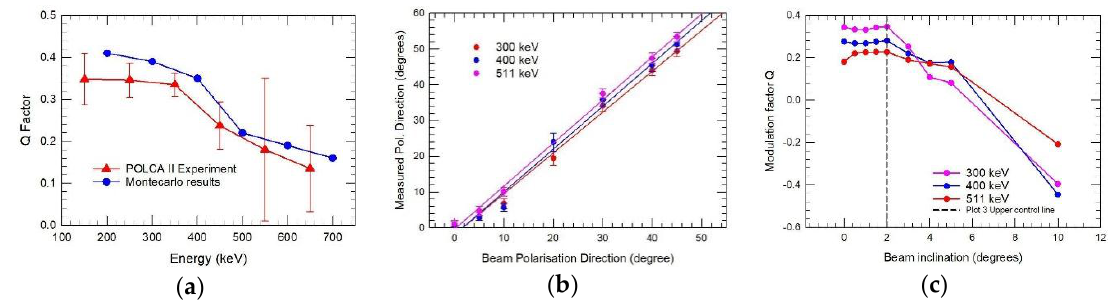
Figure 5. ( a ) The measured PolCA modulation Q 100 factor (with 1 σ errors) as function of beam energy, compared with the results of a simple GEANT Monte Carlo model (the 1 σ errors are smaller than symbols); ( b ) The polarization plane direction reconstruction (with 1 σ errors) at different energies; and, ( c ) Systematic effect induced in the measure of the modulation factor Q 100 by the zenithal inclination of the impinging photons.